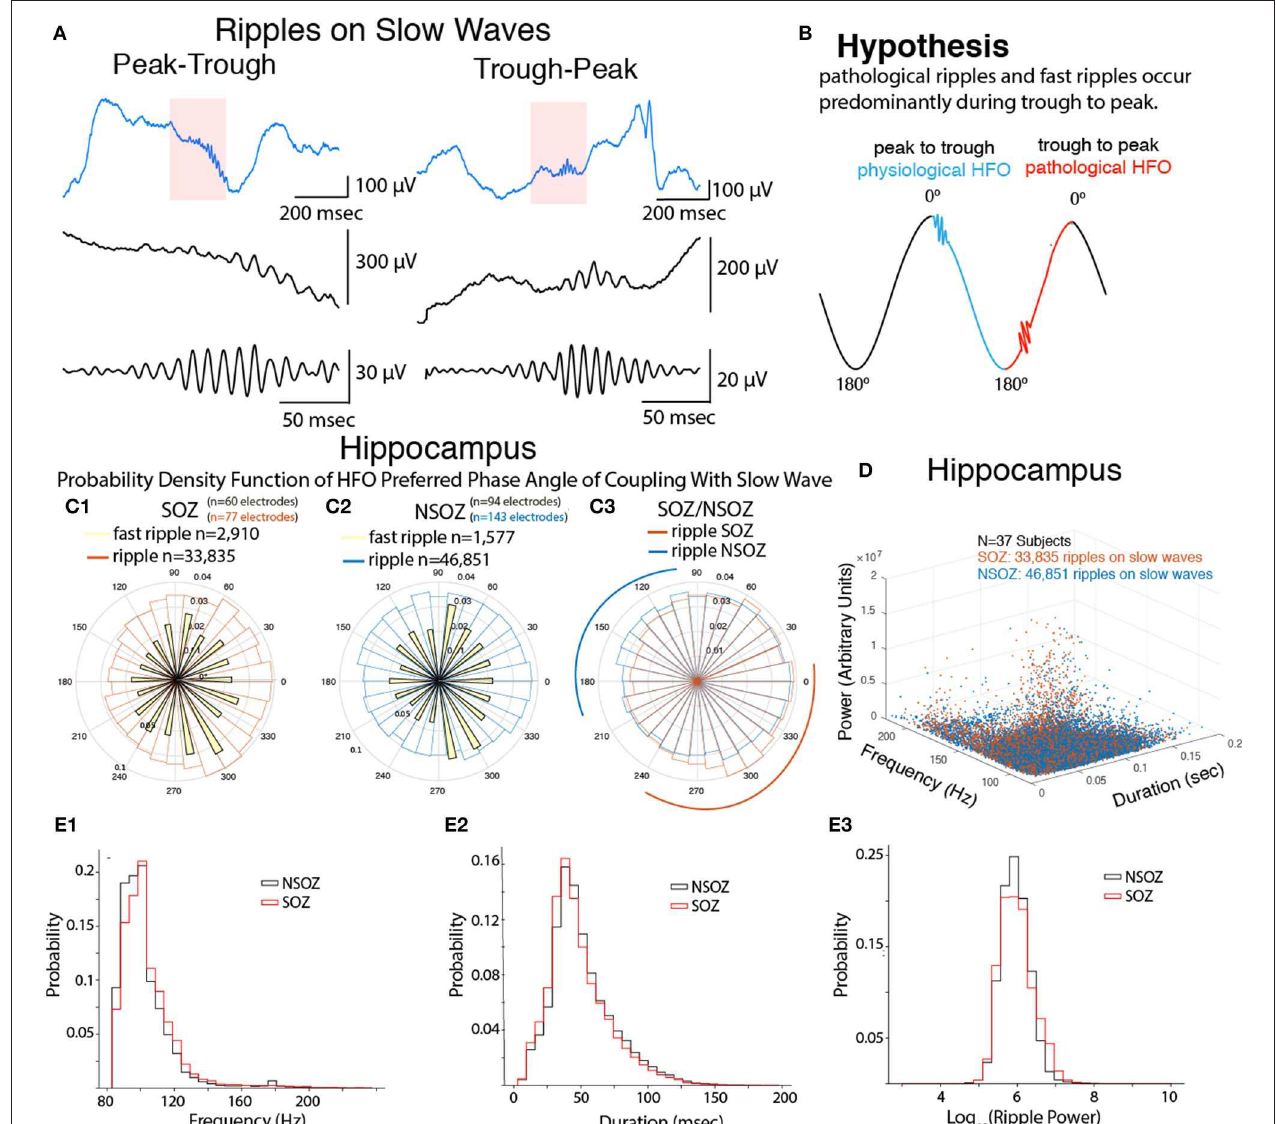
FIGURE 1 | Fast ripples and ripples in the hippocampal seizure-onset zone (SOZ) are coupled with the trough-peak of the slow wave and exhibit distinct properties. (A) Example of ripples on slow waves during the peak-trough (or Off-On; left) and trough-peak (or On-Off; right) transition, (middle) ripples at an expanded time scale, (bottom) band-pass filtered ripples. (B) Illustration of main hypothesis pathological ripples and fast ripples preferentially occur during the trough-peak transition of the slow wave. (C) Normalized circular histogram [i.e., probability density function(PDF)] of fast ripple (yellow) and ripple [SOZ: red, non-SOZ(NSOZ): blue] preferred phase angle of coupling with respect to the slow wave measured in the SOZ (C1) and NSOZ (C2) . A direct comparison of ripple preferred phase angle of coupling in the SOZ and NSOZ is shown in (C3) where arcs represent regions where the SOZ PDF exceed the NSOZ PDF (red) and vice versa (blue). (D) Three dimensional scatter plot of ripple on slow wave properties in the SOZ (red) and NSOZ (blue). (E) Normalized histogram of the ripple on slow wave properties in the SOZ (red) and NSOZ